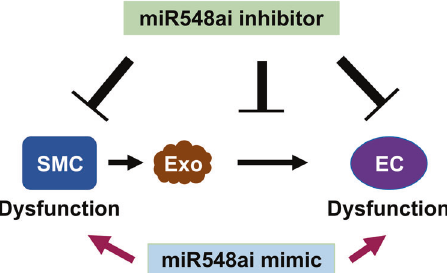
Fig. 7 Schematic working model for the effect of miR548ai antagonism on EC and SMC dysfunction. Whereas exosomes (Exo) derived from dysfunctional SMCs induce EC dysfunction, miR548ai inhibitor mitigates this effect. miR548ai mimic exacerbates, and miR548ai inhibitor attenuates EC and SMC